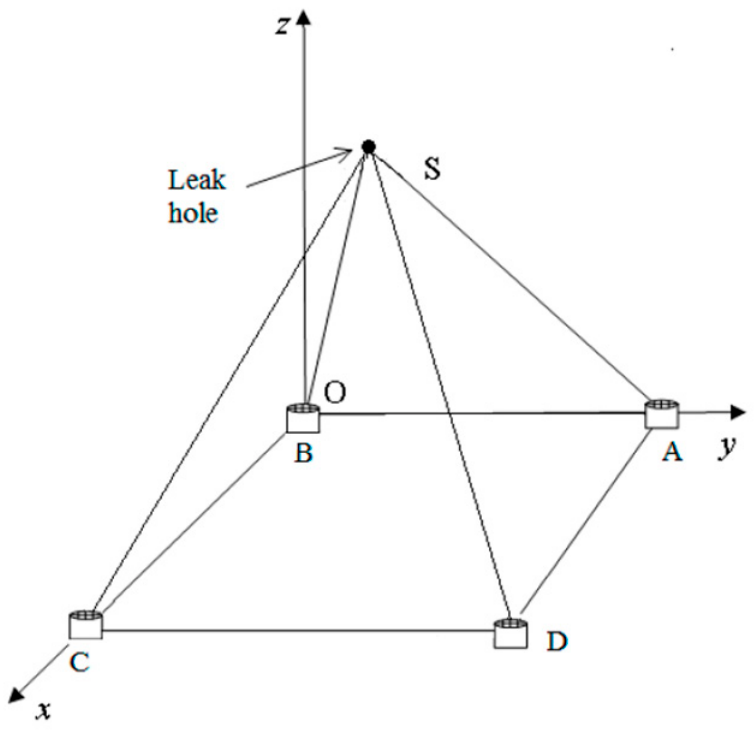
Figure 6. The concept of the beamforming method, with each sensor focusing on the leak [66].